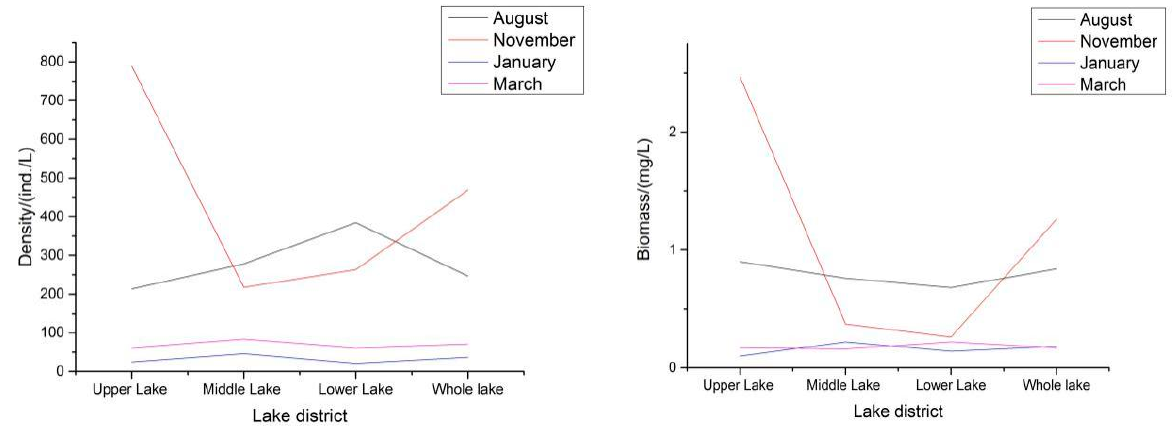
Figure 2. The trends in the zooplankton density and biomass in each lake area of Shengjin Lake.